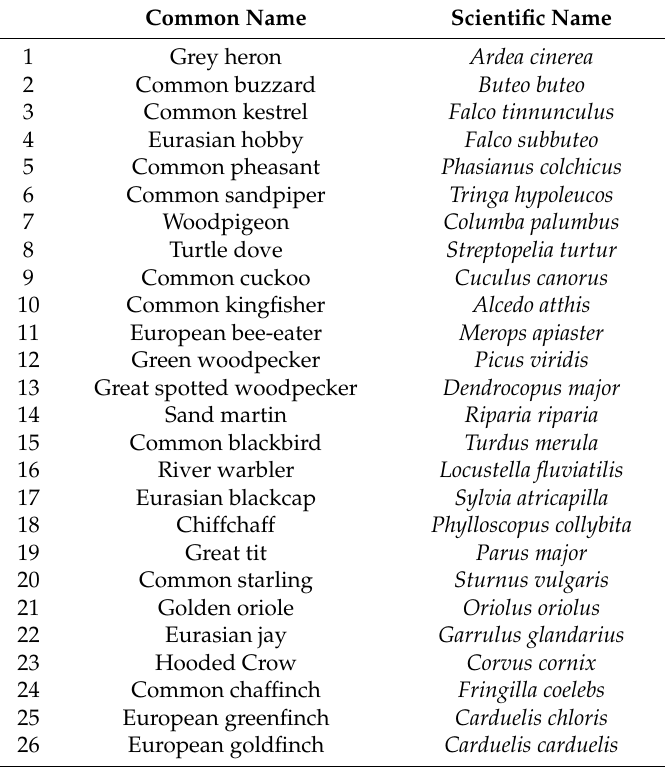
Figure 10. Biplot of the PCA model conducted with the landscape metrics and river channel development indices (dashed arrows: involved variables). Table 3. List of bird species seen and/or heard during the censuses listed in taxonomic